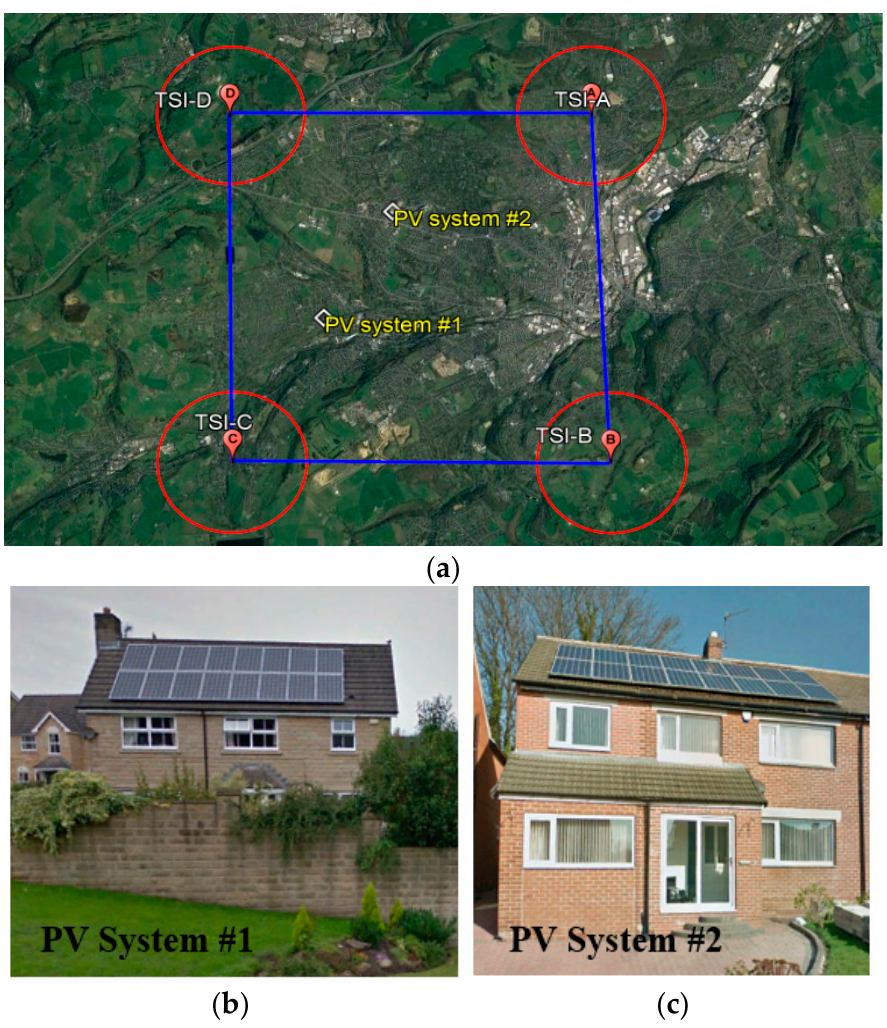
Figure 8. PV setups: ( a ) map representing the locations of the examined PV systems and ( b , c ) physical images of the PV systems.